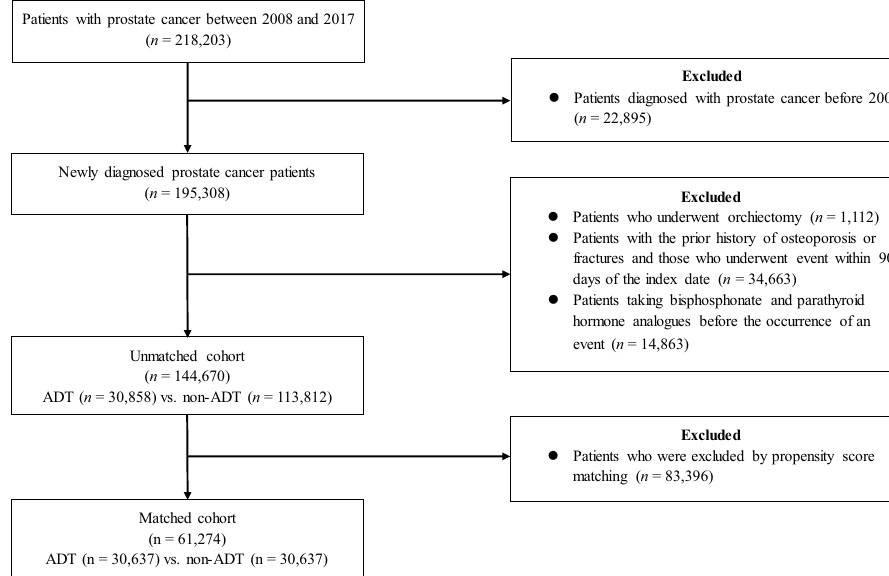
Figure 1. Flow diagram outlining the enrollment of the patient